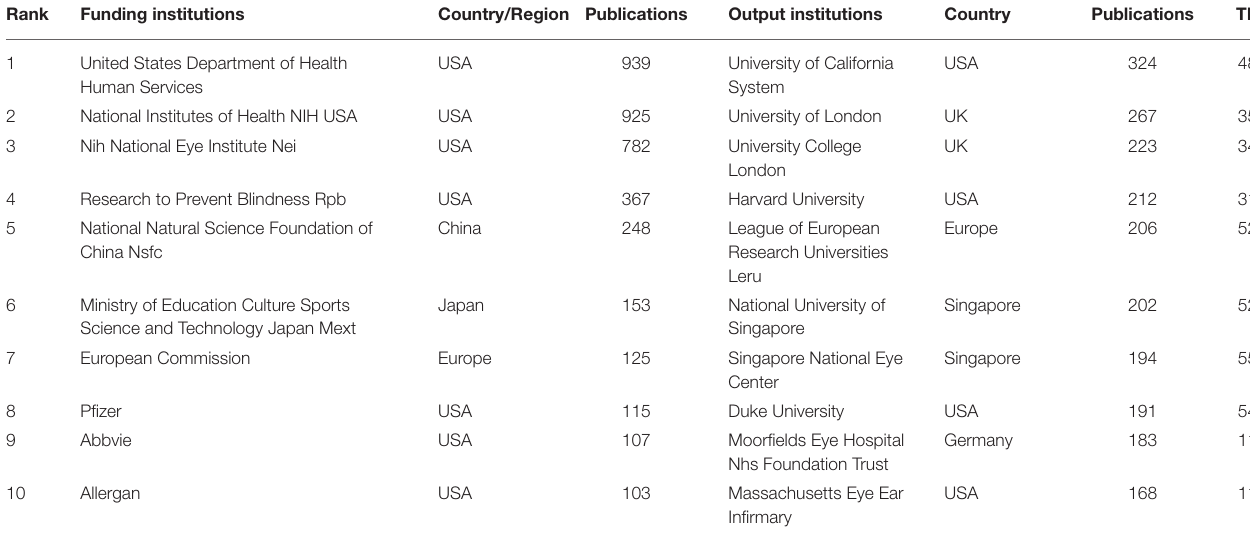
TABLE 2 | The top 10 funding institutions and output institutions in the study of POAG. Rank